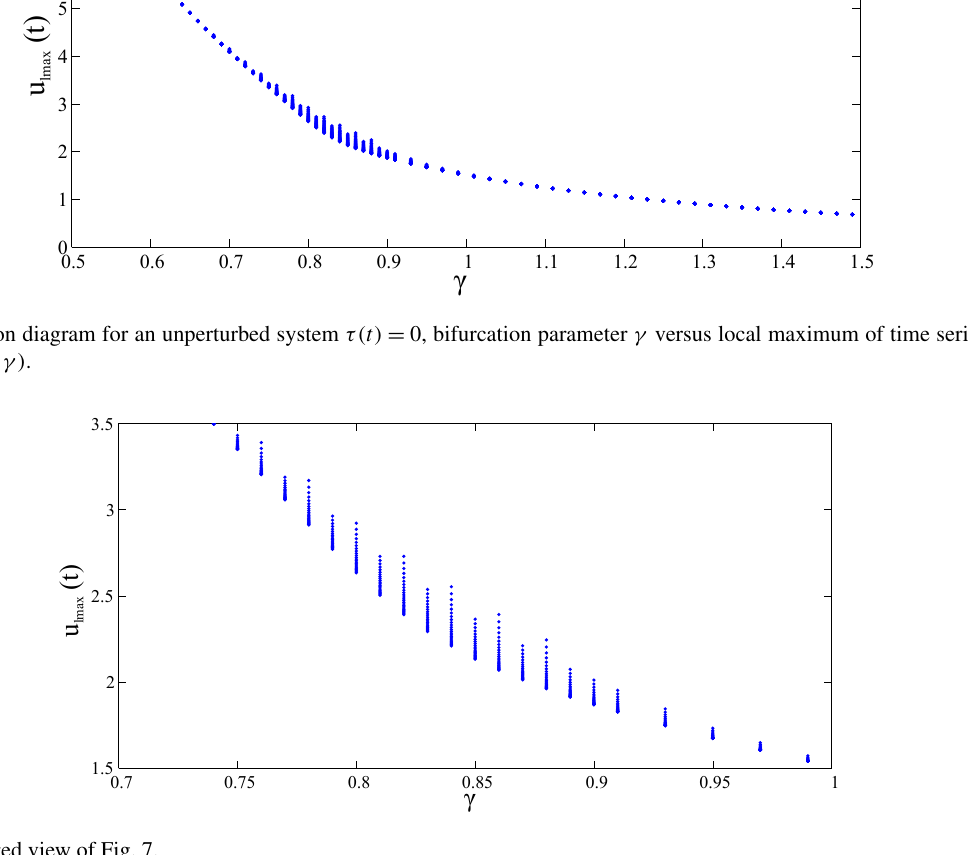
Figure 8. An enlarged view of Fig.